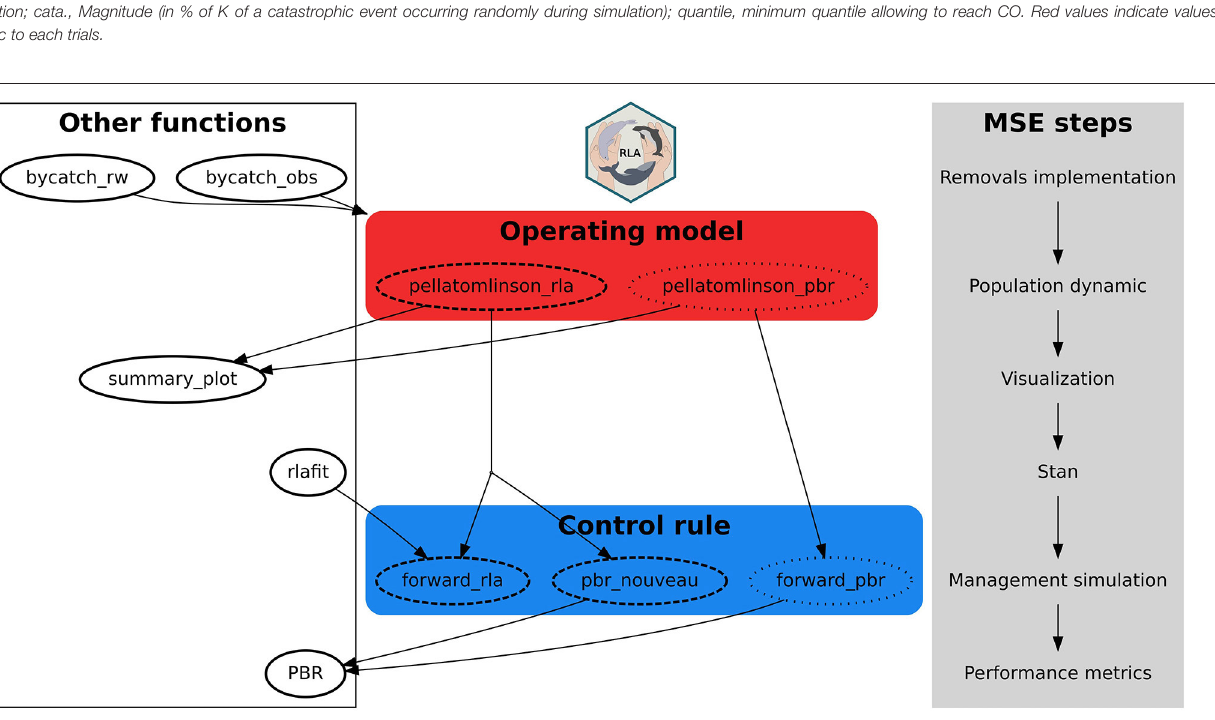
FIGURE 6 | Package structure with the core functions to carry out Management Strategy Evaluation